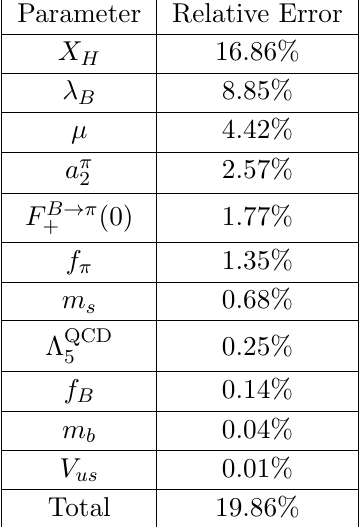
19 : 86% (0) is the relevant form factor for the transitions + is the second 2